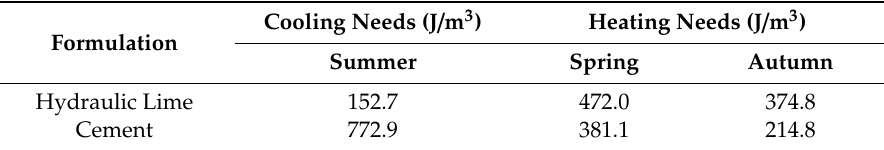
Table 7. Energy savings per day for mortars containing PCM